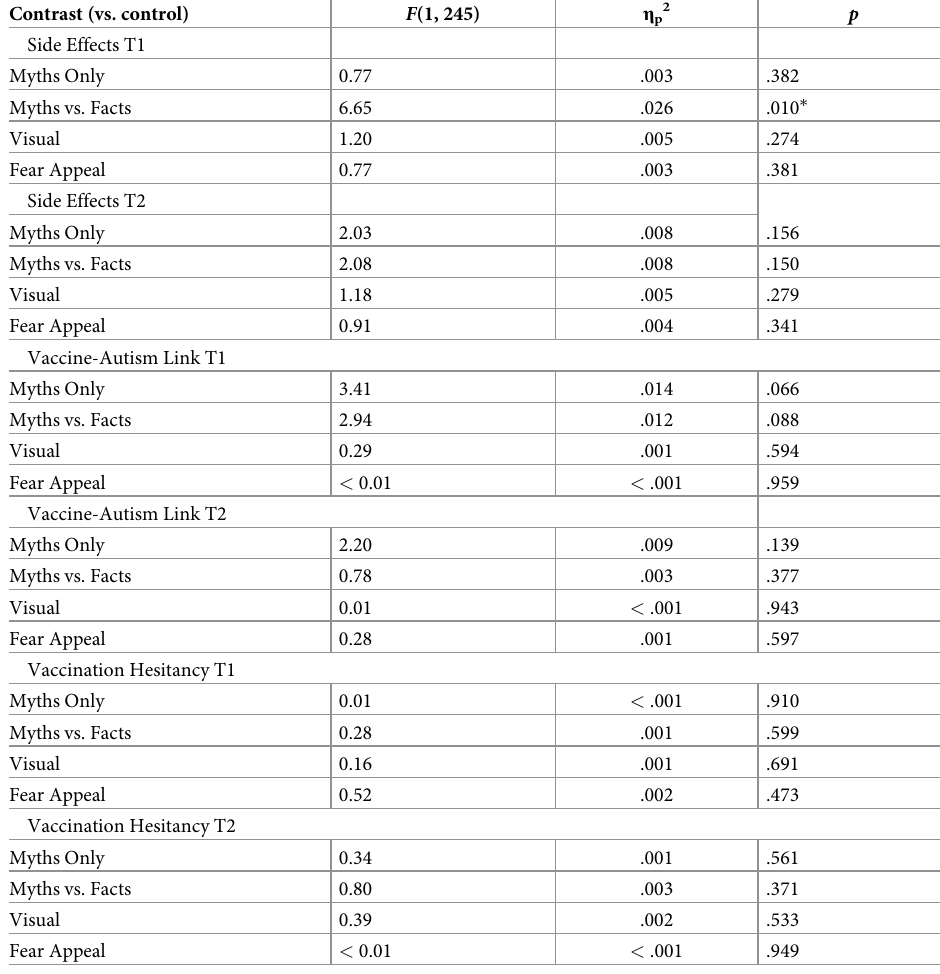
Pre-post analyses. Backfire effects are defined by an ironic increase in belief relative to either a control condition (as used in the primary analyses) or a pre-manipulation baseline (Swire-Thompson et al., 2020). We therefore conducted pre-post analyses, using a composite measure based on the three items administered at all time points (T0, T1, T2). Data are shown in Fig 7. First, a between-subjects ANOVA with the sole factor of condition (control, myths only, myths vs. facts, visual, fear appeal) was conducted at T0, to ascertain that there were no condition differences at baseline; no differences between conditions were found, F < 1. Then, a full-factorial repeated-measures ANCOVA with the within-subject factor time (T0, T1, T2), the between-subjects factor condition (control, myths only, myths vs. facts, visual, fear appeal), and the VAX-ID covariate was conducted. This yielded a significant main effect of time F (2, 740) = 87.20, p < .001, η p2 = .191, indicating a significant decrease over timepoints. There was the expected main effect of VAX-ID, F (1, 370) = 518.51, p < .001, η p2 = .584, but no main effect of condition, F < 1. However, a significant interaction between time and condition was found, F (8, 740) = 3.35, p = .001, η p2 = .035, suggesting that the effect of the experimental